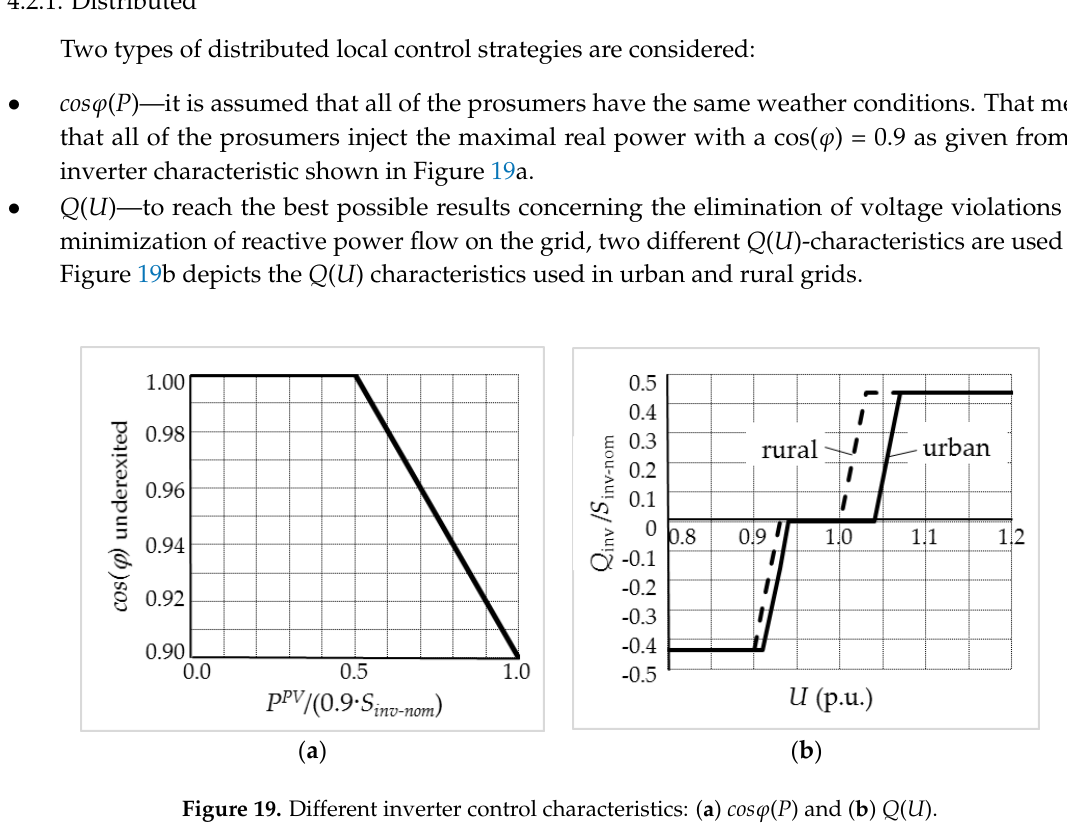
( b ) Figure 18. Schematic presentation of different real low-voltage grids (LVGs): ( a ) urban and ( b ) rural. Each prosumer is modeled by means of a ZIP load and a PV facility. The ZIP model is described